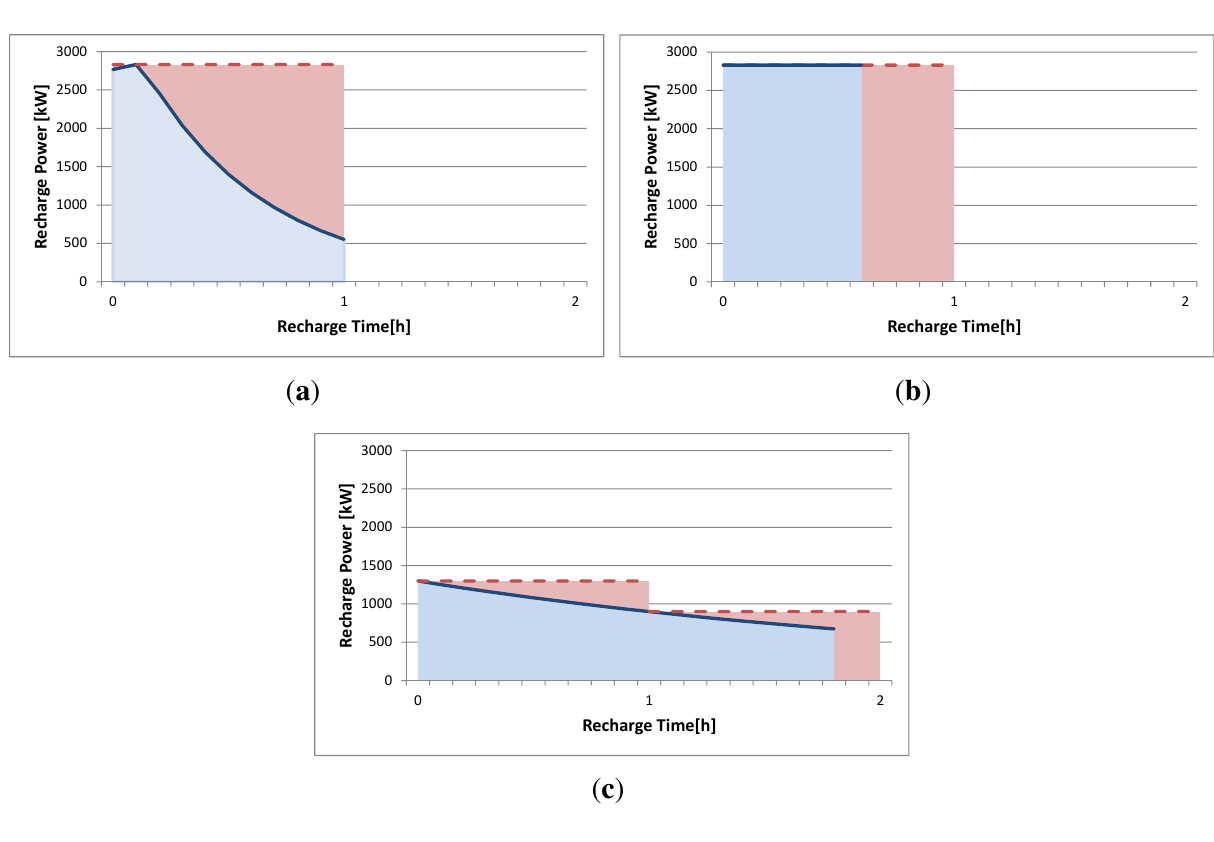
Figure 10. Recharge profile of the recharging process of three different types of